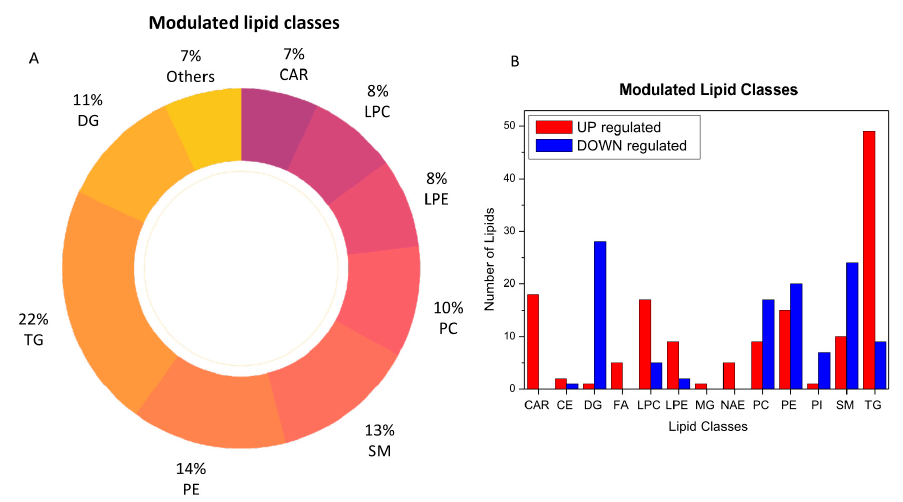
Figure 3. Modulated lipid classes caused by SARS-CoV-2 infection ( A ) and the number of upregulated (red) and downregulated (blue) lipid species within each single class of lipids ( B ). Figure 4 provides a MetaMapp visualization of lipidomic changes in COVID-19 patients. Red nodes represent lipids with increased concentration, while blue nodes represent lipids with decreased concentration. PCs were significantly downregulated (65.4%) as a consequence of the infection. The levels of PC (14:0_22:6), PC (16:1_22:6), PC (14:0_18:2), and PC (O-16:1_18:2) were the most decreased, with fold changes of 0.305, 0.443, 0.395, and 0.495, respectively. We also observed that the 57.1% of the glycerophosphoethanolamines were downregulated, while several free fatty acids were upregulated (FA 18:1, FA 18:2, FA 22:6, FA 44:5, and FA 20:4).